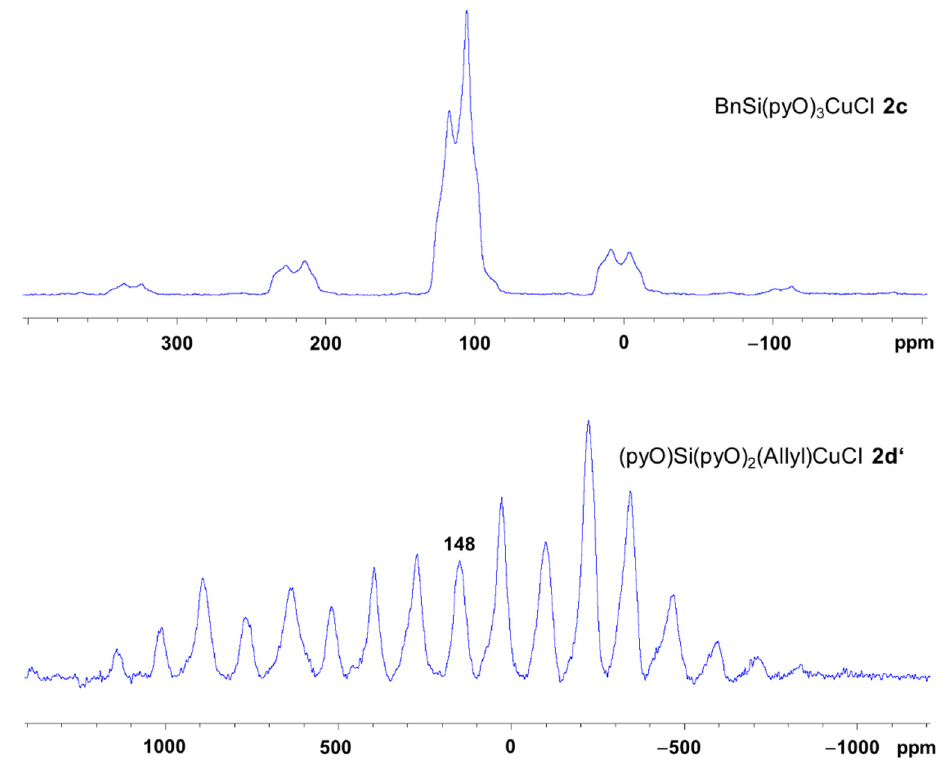
Figure 9. 63 Cu MAS NMR spectra of 2c and 2d ′ recorded at υ rot = 20 kHz and 23 kHz, respectively. The central band in the spectrum of 2c indicates the range of the location of δ iso . In case of 2d ′ , an additional spectrum was recorded at a different spinning frequency to identify the band at 148 ppm as the region in which δ iso is located.